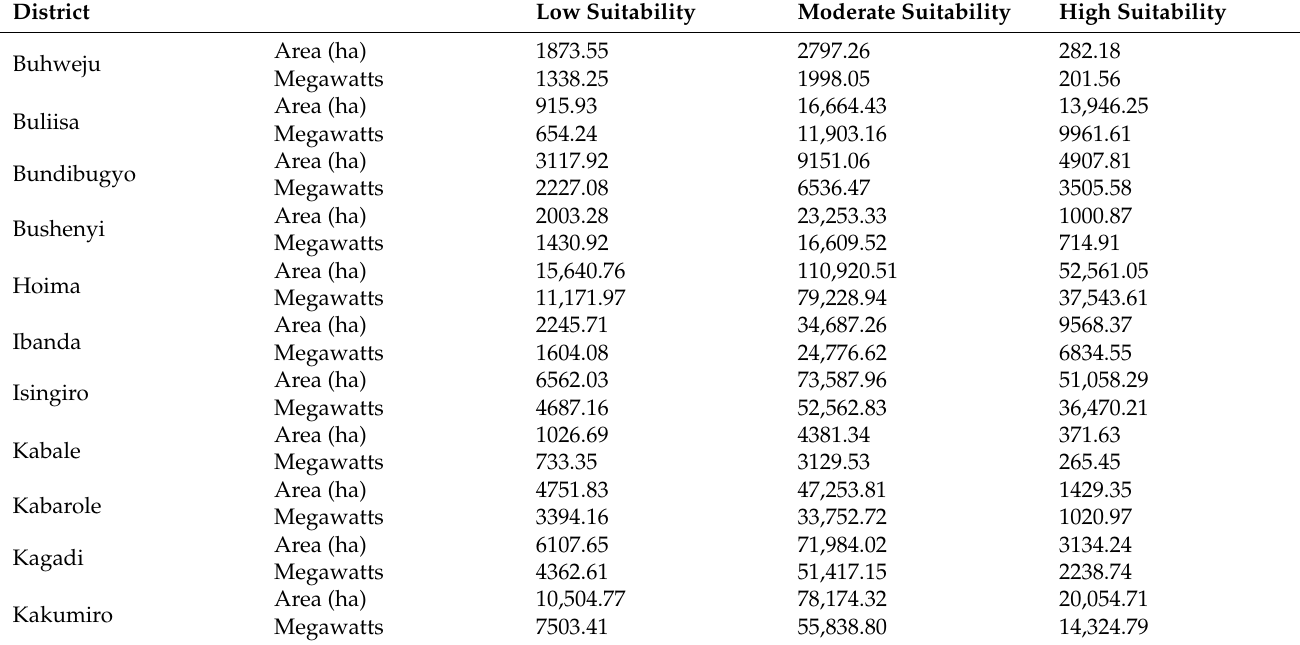
Table A4. Suitability of solar sites for power